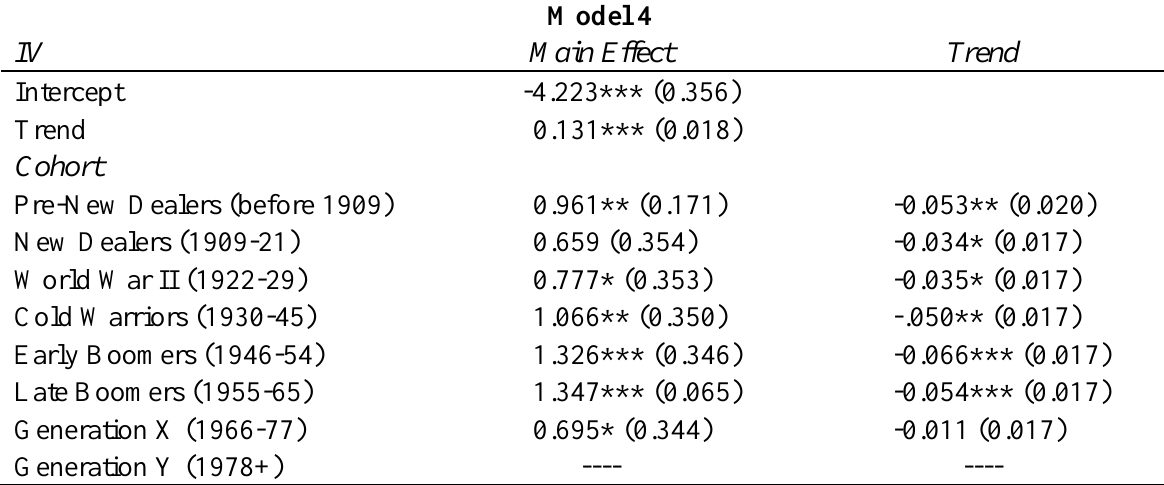
Table 3. Negative Binomial Models Predicting Self-Reported Fertility over